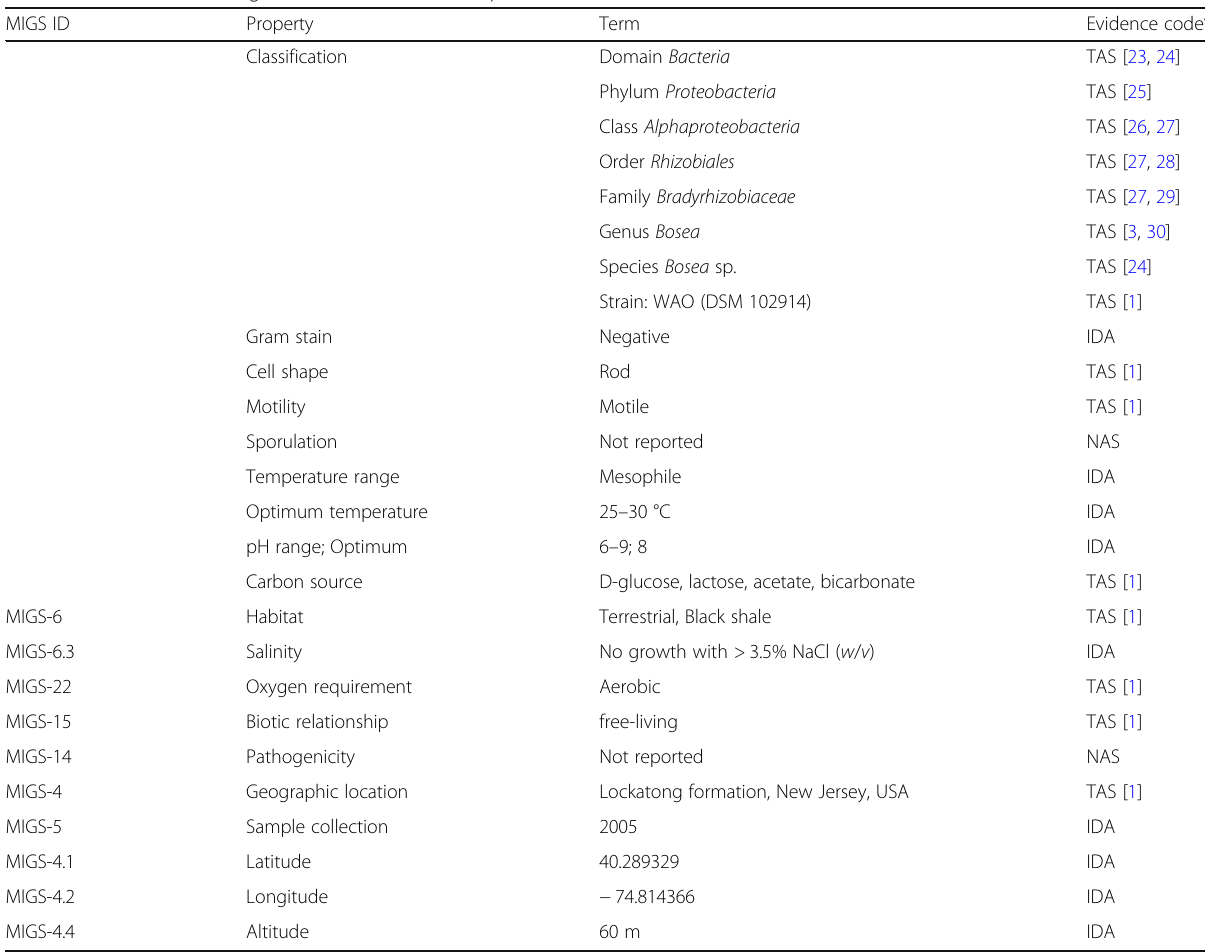
Table 1 Classification and general features of Bosea sp. WAO